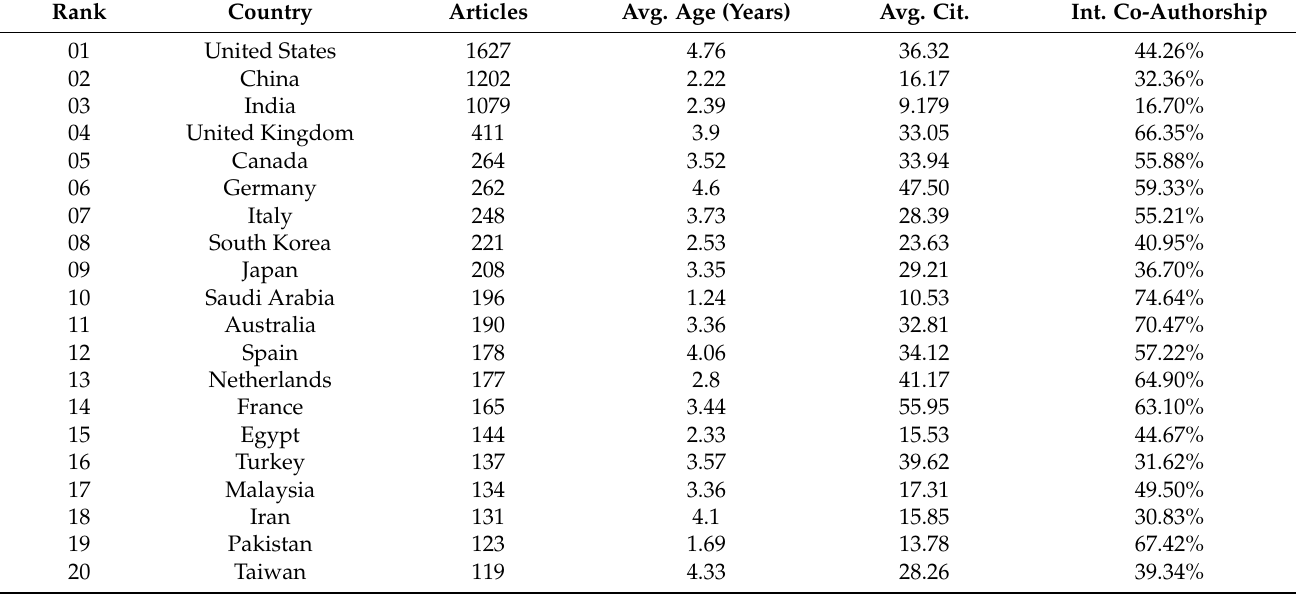
Table 4. Overview of the countries with the most